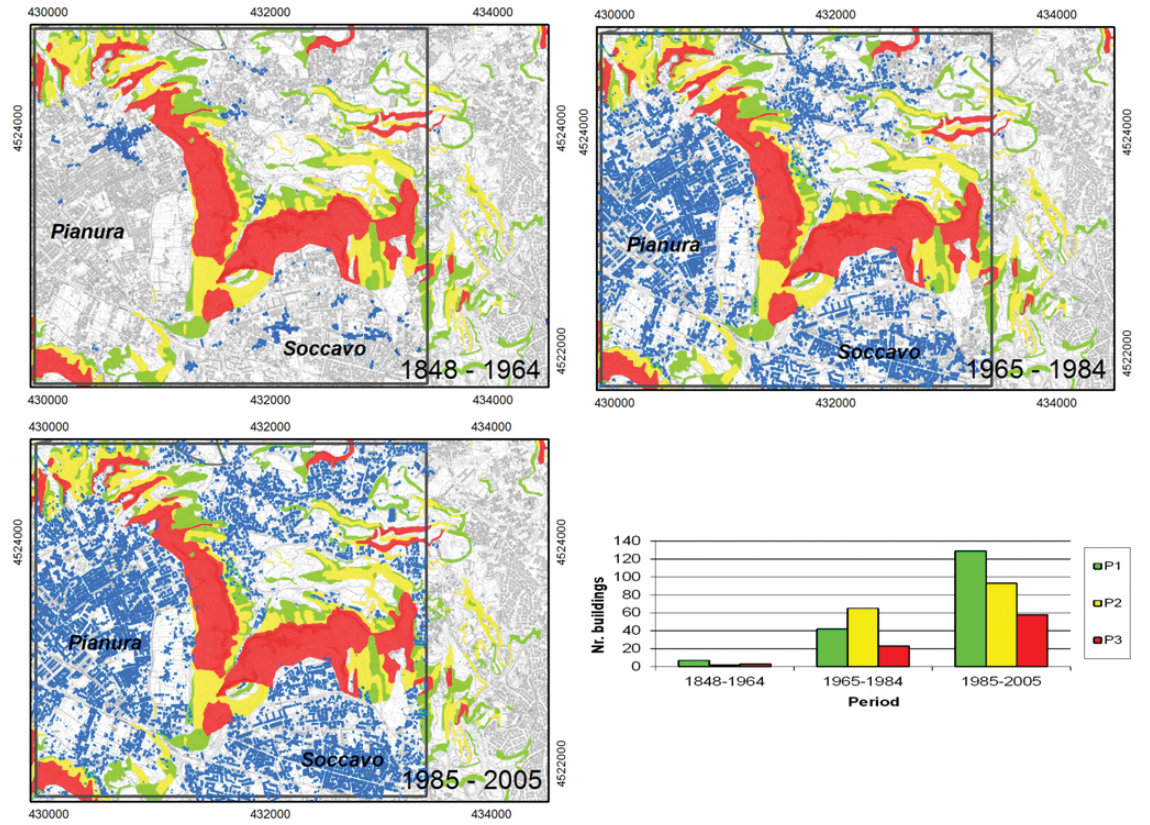
Fig. 19. 1848–2005 temporal distribution of the dwellings built around the Camaldoli hill, Naples. Key to symbols: P1 = low relative hazard; P2 = medium relative hazard; P3 = high relative